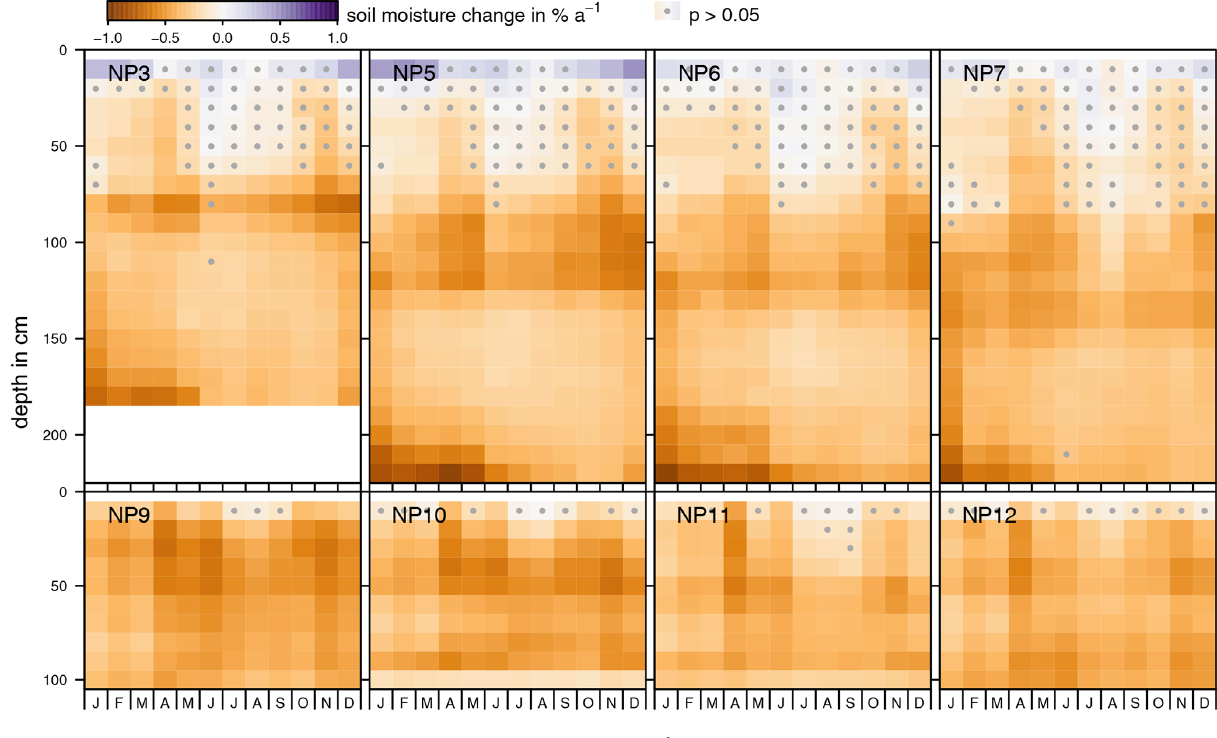
Figure 9. Results of individual linear regressions for soil moisture measurements in the recultivation layer, expressed as change in soil (cid:104) (cid:105) moisture content %a − 1 calculated over the complete time series for each month based on monthly averages. Upper graphs: Field 2, lower graphs: Field 1. Values for p > 0 . 05 are indicated by a